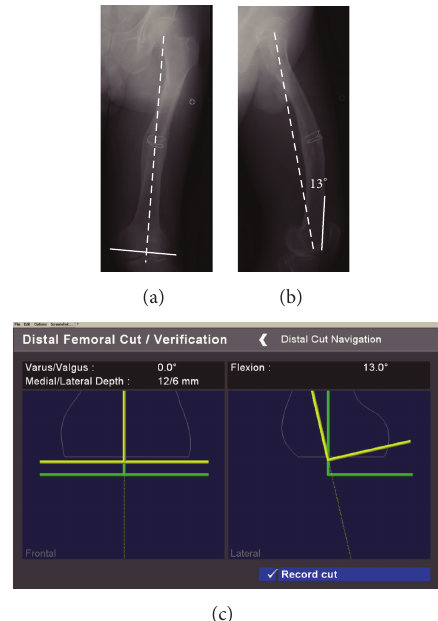
Figure 2: Estimated distal femoral cut line (solid line) perpendicu- lar to the mechanical axis (dashed line) does not compromise the collateral attachment in anteroposterior radiograph (a). Anterior femoral surface (solid line) is 13 ∘ flextion to the mechanical axis (dashed line) in lateral view (b). Intraoperative estimation of the distal femoral cut line and thickness of the resected bones were calculated by the navigation system